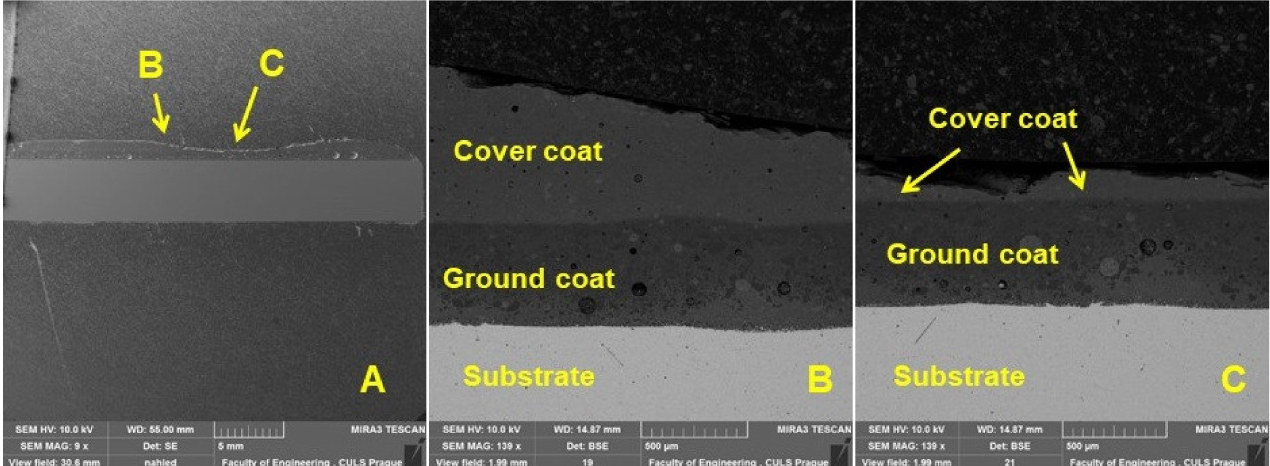
Figure 14. SEM analysis of the section of the test specimen after wear: ( A ): longitudinal section of the tested specimen after wear (MAG 9 × , ( B ): longitudinal section in the area of the leading surface of the rubber disc during the wear process of the enamel surface (MAG 139 × ), ( C ): longitudinal section in areas of the central part of the worn enamel surface (MAG 139 ×